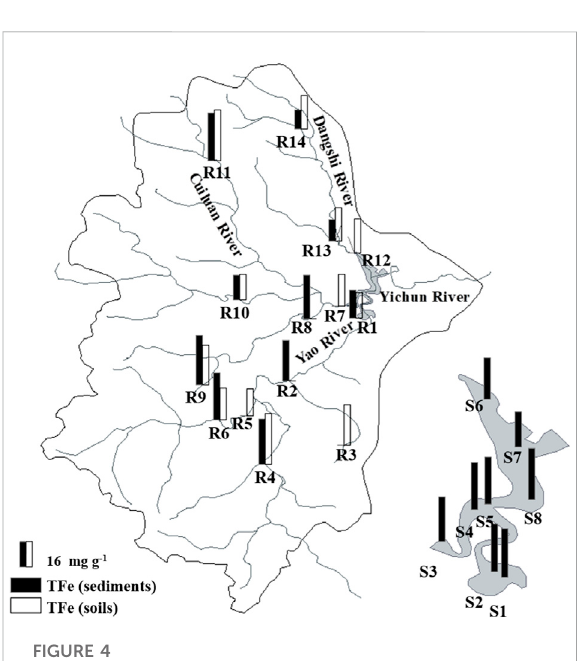
FIGURE 4 Spatial distribution characteristics of the TFe content in soils and sediments of the Xishan Reservoir drainage area.